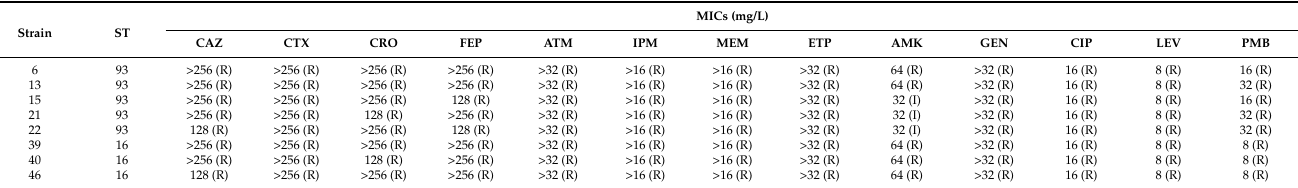
Table A2. Phenotypic characterization of polymyxin-resistant K. aerogenes